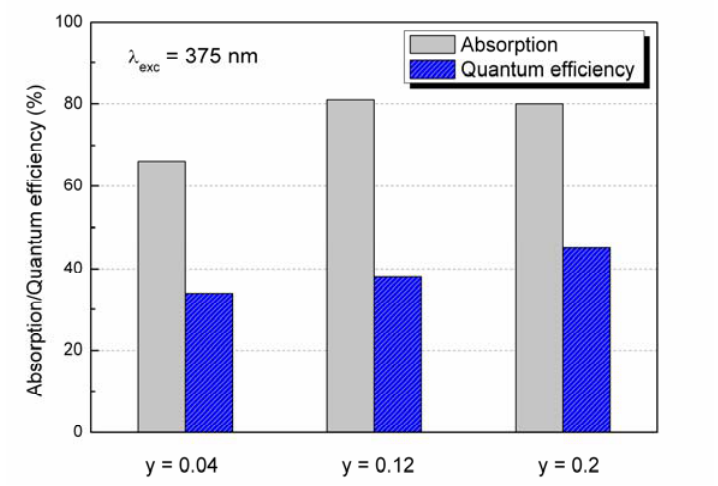
Eu Si O N for x = 0 and 0.1 3.88 0.12 6 16-3x/2 x